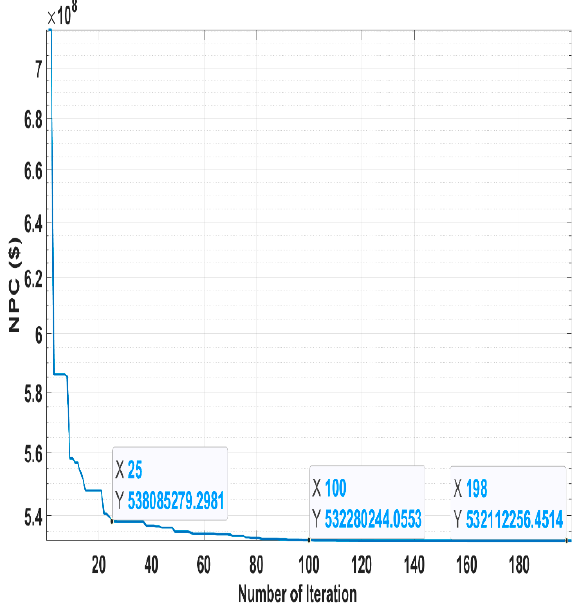
Figure 11. Convergence Plot (Case-04).